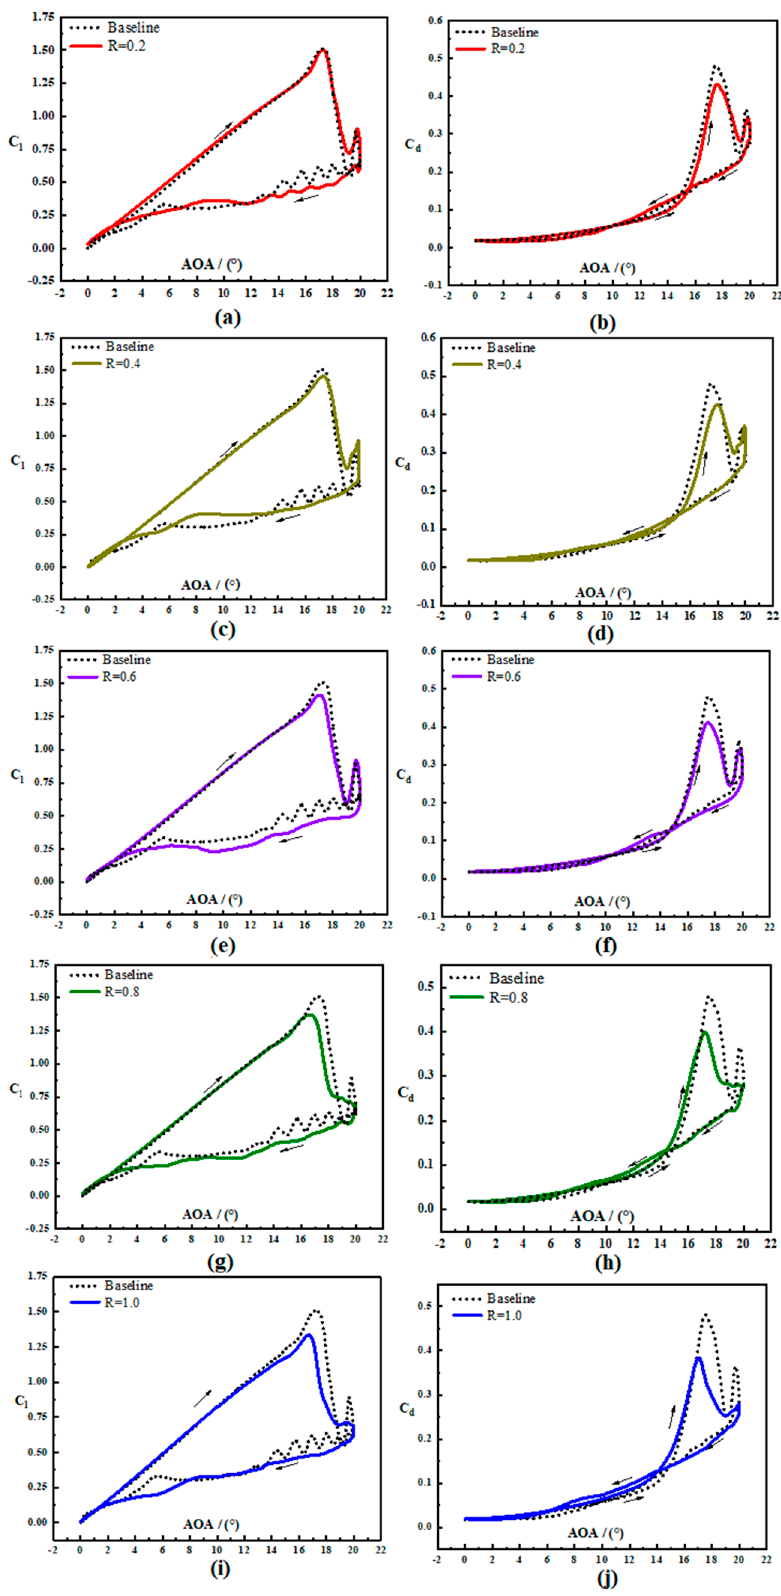
Figure 12. Lift coefficients for different airfoils. ( a ) C l for R = 0.2; ( b ) C d for R = 0.2; ( c ) C l for R = 0.4; ( d ) C d for R = 0.4; ( e ) C l for R = 0.6; ( f ) C d for R = 0.6; ( g ) C l for R = 0.8; ( h ) C d for R = 0.8; ( i ) C l for R = 1.0; ( j ) C d for R = 1.0.